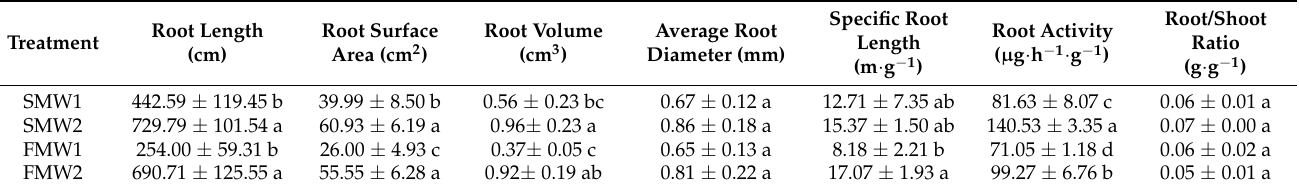
Table 3. Root length, surface area, volume, average root diameter, specific root length, root activity, and root/shoot ratio of tomato plants under different